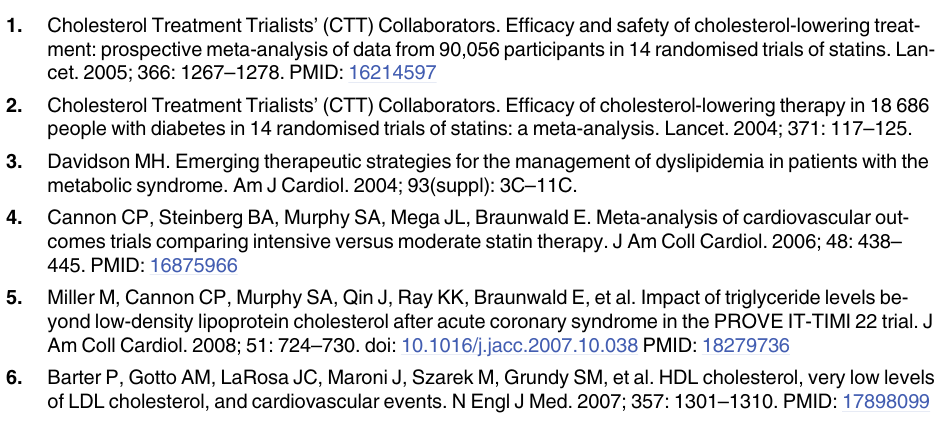
S1 Fig. Percent of patients with triglyceride levels < 1.7 mmol/L and (cid:1) 1.7 mmol/L, without (open bars) and with (closed bars) statin treatment. Values on top of columns are n (%). S1 RIACE Investigators. Participating diabetes centers. S1 Table. Clinical characteristics of type 2 diabetic subjects from the RIACE cohort strati- fied by triglyceride levels and statin treatment. S2 Table. Microvascular complications and cardiovascular disease in type 2 diabetic sub- jects from the RIACE cohort stratified by triglyceride levels and statin